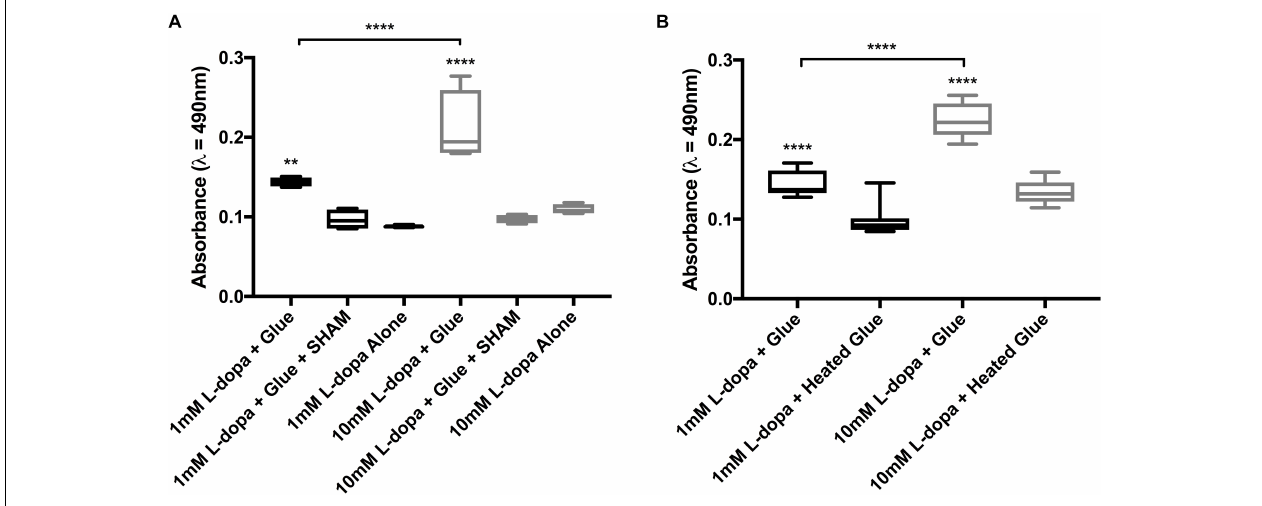
FIGURE 4 | Endpoint data from colorimetric assays of diphenolase activity in barnacle glue, taken at 30 min. (A) Activity with 1 and 10 mM substrate (L-dopa), inhibitor (SHAM) and control with substrate alone. (B) Activity with both substrate concentrations and glue untreated as compared to heated prior to the assay. Significance is indicated by asterisks ( ∗∗ p < 0.01 and ∗∗∗∗ p <